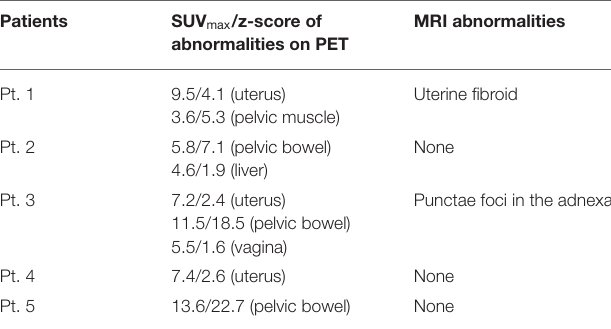
TABLE 1 | Abnormal S1R PET/MRI findings potentially associated with the patient’s pelvic pain symptom.